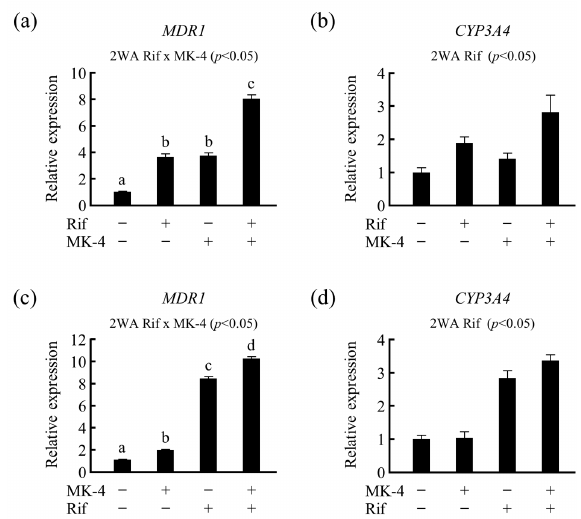
Figure 6. Effects of drug–nutrient interaction on drug metabolism-related gene expression. Effects of Rif pretreatment on the mRNA levels of ( a ) MDR1 and ( b ) CYP3A4 in LS180 cells were analyzed after 24 h of menaquinone-4 (MK-4) treatment. Similarly, the effects of MK-4 pretreatment on the mRNA levels of ( c ) MDR1 and ( d ) CYP3A4 in LS180 cells were analyzed after 24 h of Rif treatment. mRNA levels were measured using quantitative RT-PCR. Relative mRNA levels were normalized to that of eukaryotic translation elongation factor 1 α 1 mRNA. Data are expressed as the mean ± standard error of the mean, n = 3. Data were analyzed using two-way analysis of variance. Different letters indicate significant difference. MDR1 , multi-drug resistance; CYP3A4 , cytochrome P450 3A subfamily 4; Rif, rifampicin; RT-PCR, reverse transcription polymerase chain reaction.